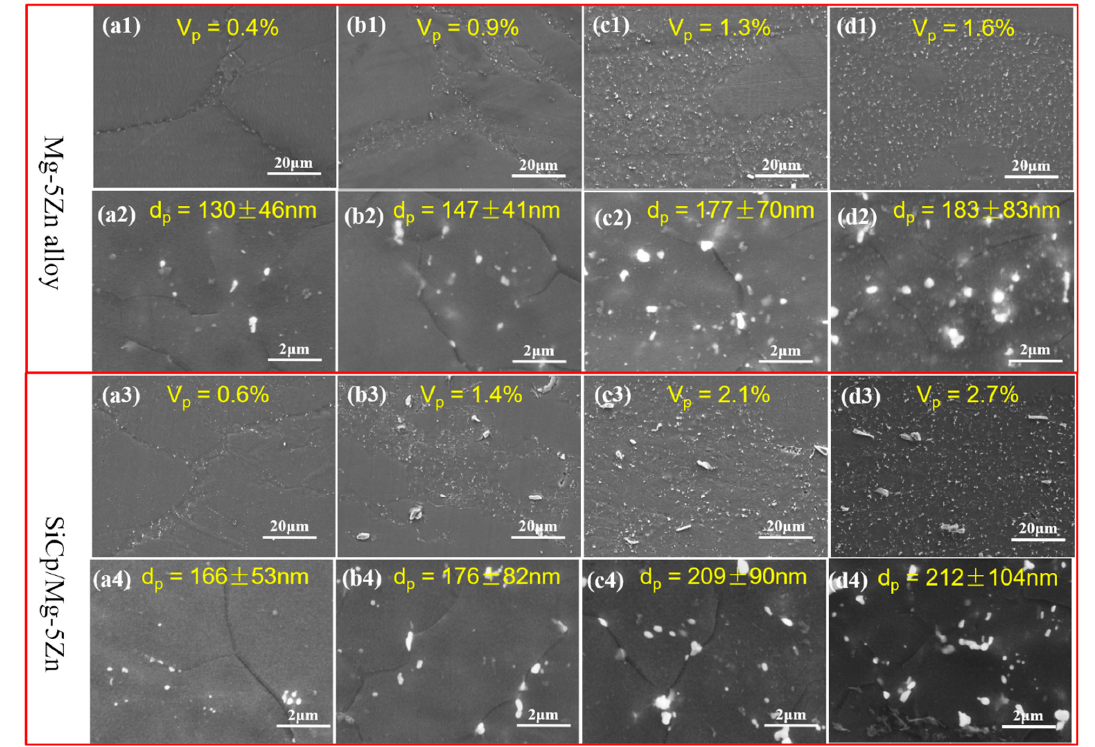
Figure 11. SEM microstructures of the Mg-5Zn alloy and the SiC p /Mg-5Zn material with different compression strains: ( a1 – a4 ) 0.05, ( b1 – b4 ) 0.1, ( c1 – c4 ) 0.35 and ( d1 – d4 ) 0.7. Figure 13 gives the TEM microstructure of the Mg-5Zn alloy with a compression strain of ~0.1. It can be seen that the Mg-Zn phase was mainly distributed along the grain boundary (Figure 13a); this result is consistent with SEM. Further combining with the se- lected diffraction analysis results, the precipitated phase in the Mg-5Zn alloy can be iden- tified as the MgZn 2 phase. In addition, the interface relationship between the MgZn 2 phase and the Mg matrix can be obtained through HRTEM analysis. It can be seen that the (110) plane of MgZn 2 phase was parallel to the (100) plane of Mg ((110) MgZn2 //(100) Mg ), as shown in Figure 13b,in which, the plane distance of (110) of MgZn 2 was ~0.263 nm, and the plane distance of (100) of Mg was ~0.278 nm. Therefore, the interface mismatch between MgZn 2 and Mg matrix can be calculated as ~5.3% by Equation (1) [18], indicating that the interface bonding was good.